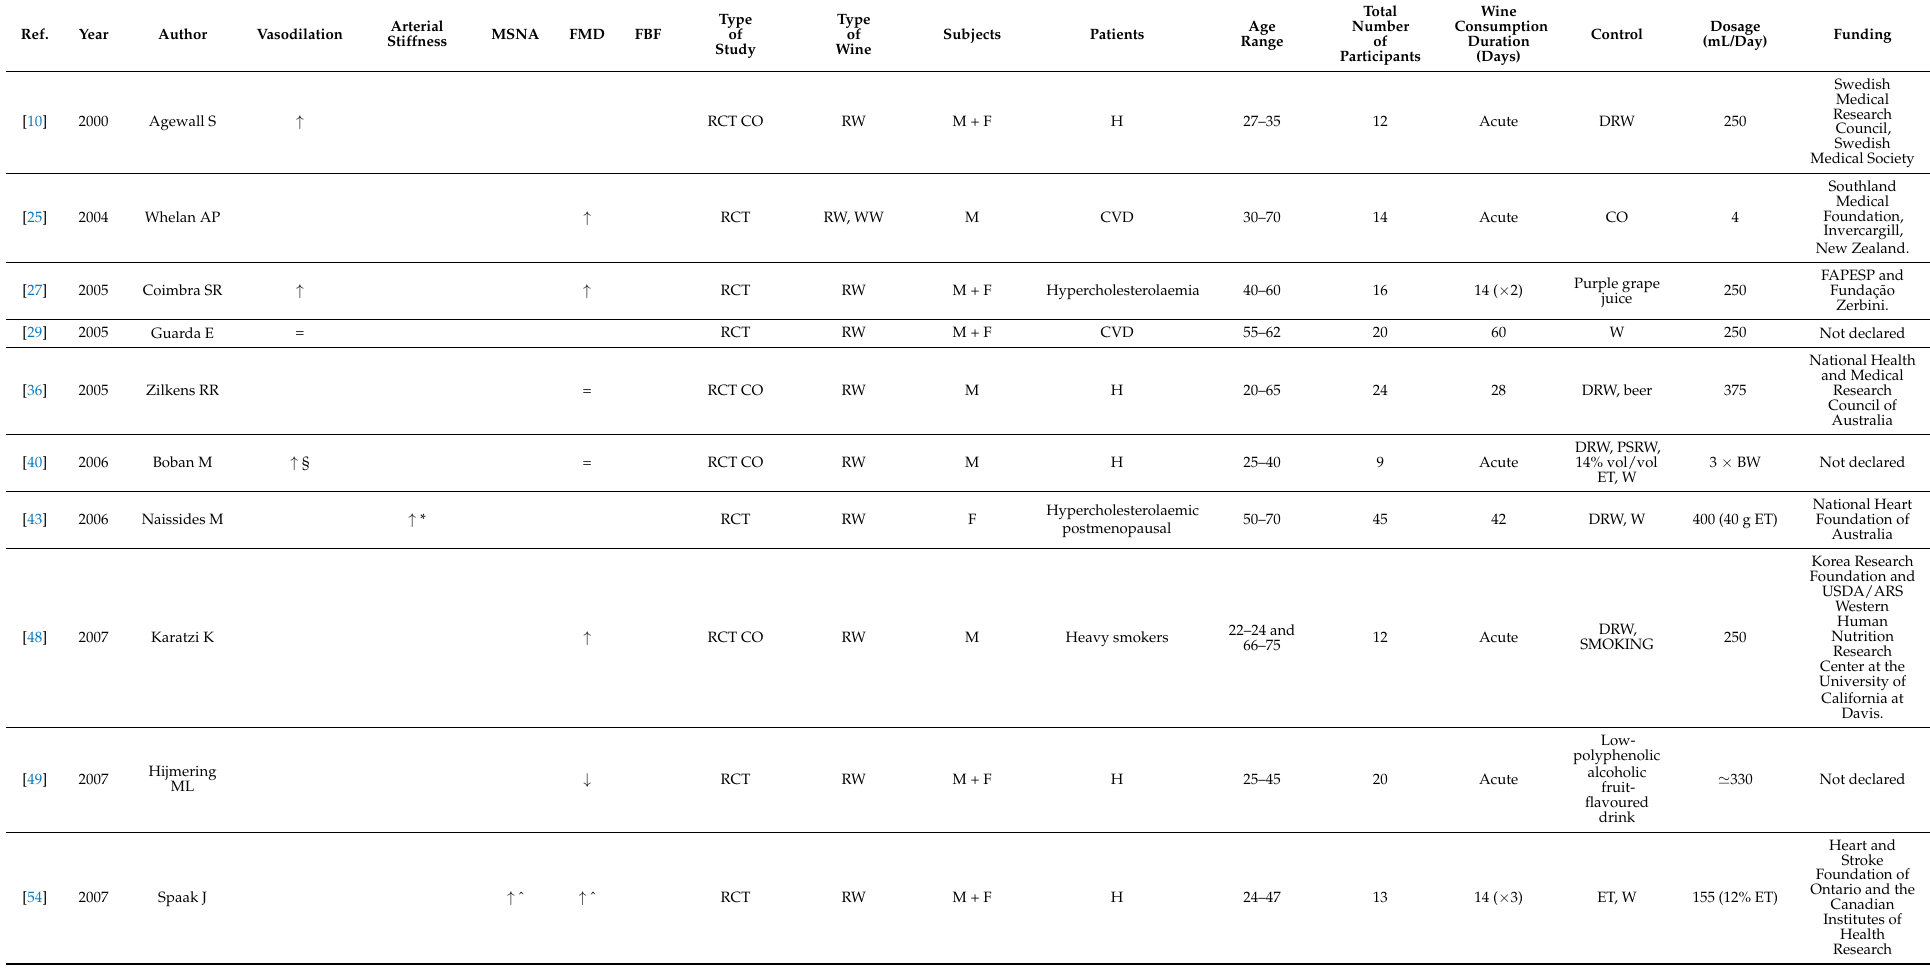
Table 4. Overview of studies that evaluated the effects of red wine consumption on endothelial function and arterial stiffness.